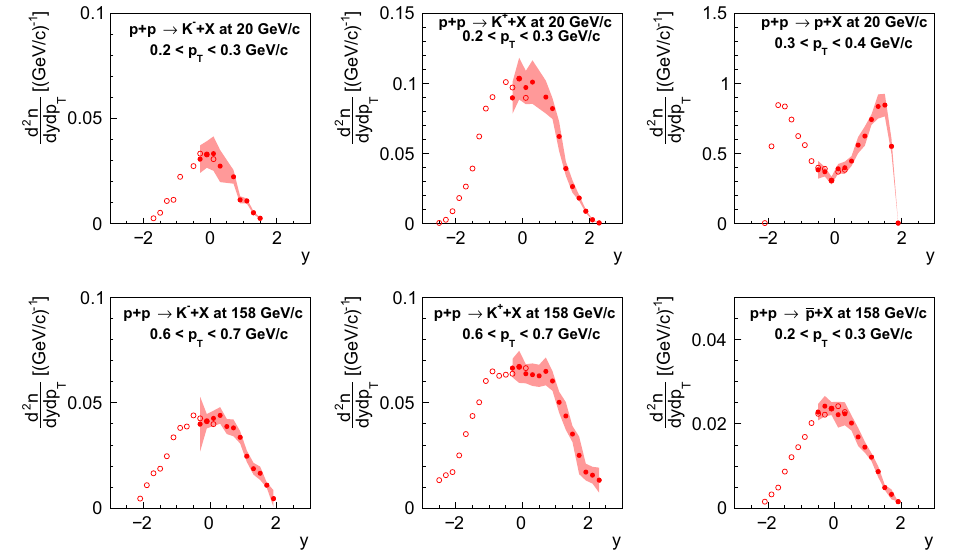
Fig. 22 Rapidity spectra of K − , K + and p measured (filled dots) and reflected with respect to mid-rapidity (open dots) obtained in inelastic p + p interactions in the interval p T = 0 . 2 − 0 . 3 GeV / c at 20 GeV / c (upper row) and p T = 0 . 6 − 0 . 7 GeV / c at 158 GeV / c (bottom row)